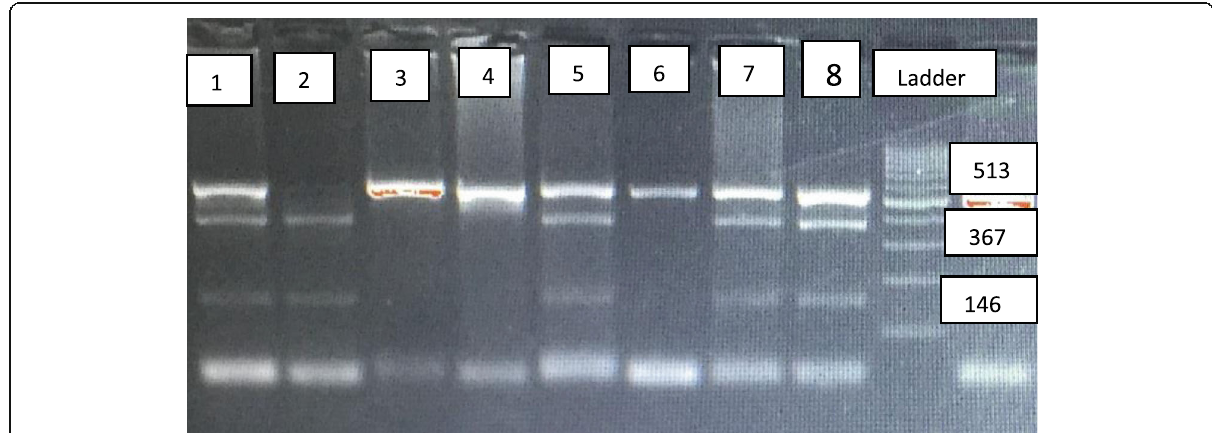
Fig. 1 Digested pcr products using Hinf 1 enzyme for C667T polymorphism. 3% agrose gel showing digested pcr products: (a) lanes 1, 5, 7, and 8 showing 513,367 and 146 bp bands (CT genotype); (b) lane (2) showing 367 and 146 bp bands (TT genotype); (c) lanes 3, 4, and 6 showing